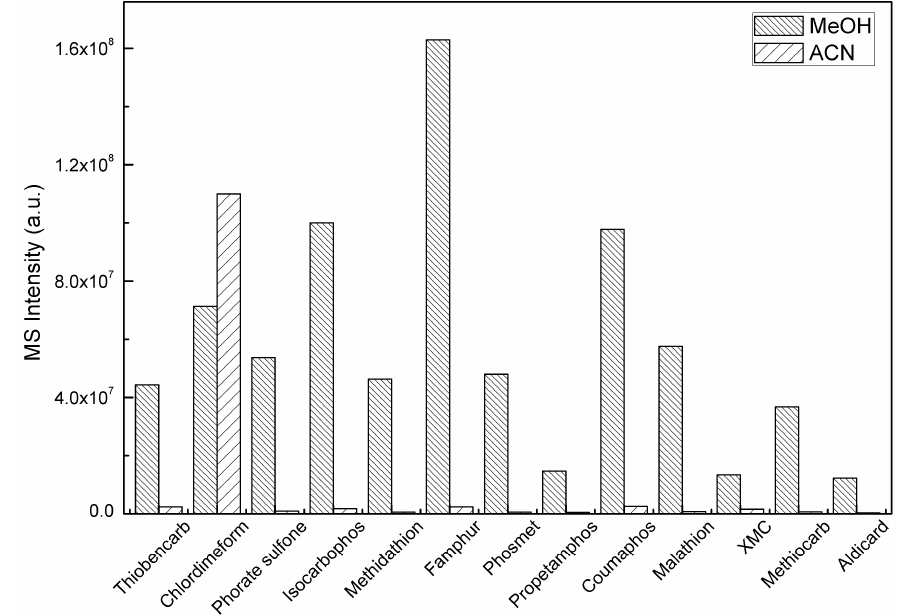
Figure 1. Pesticides with significant changes in sensitivity in MeOH and acetonitrile (ACN) mobile phases with 5 mM ammonium formate and 0.1% formic acid (FA) at the concentration of 50 ng/mL.